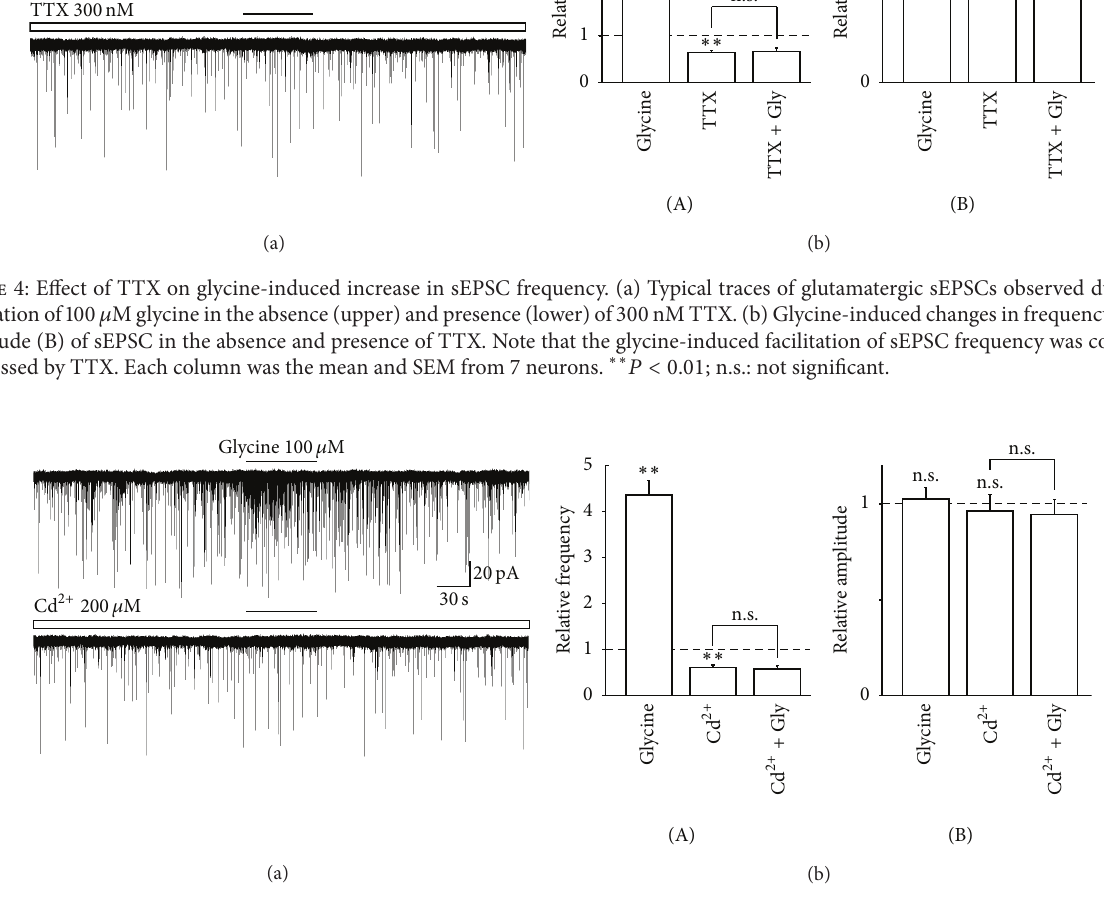
the facilitatory action of glycine ( 436.8±31.1 % of the control, 𝑛 = 6 , 𝑃 < 0.01 ) was completely occluded to 95.9 ± 10.6 % of the Cd 2+ condition ( 𝑛 = 6 , 𝑃 = 0.28 , Figures 5(a) and